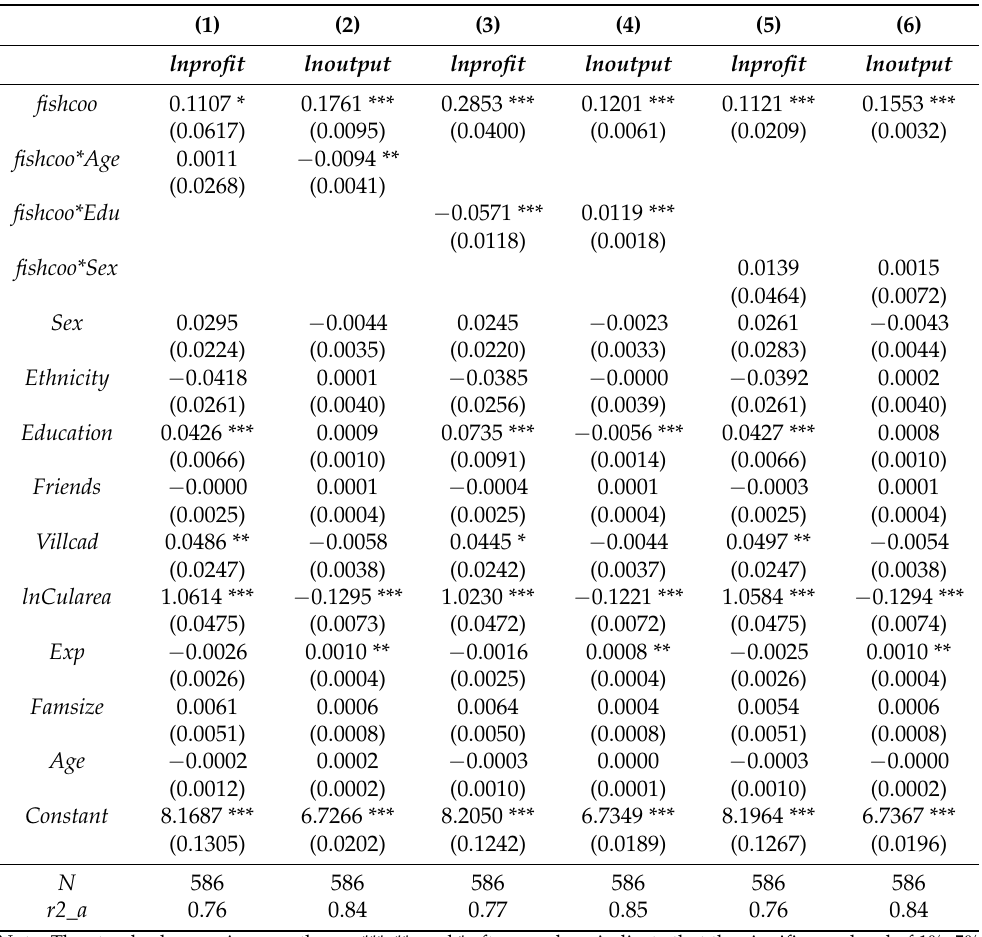
Table 4. Heterogeneity test results based on age, education, and